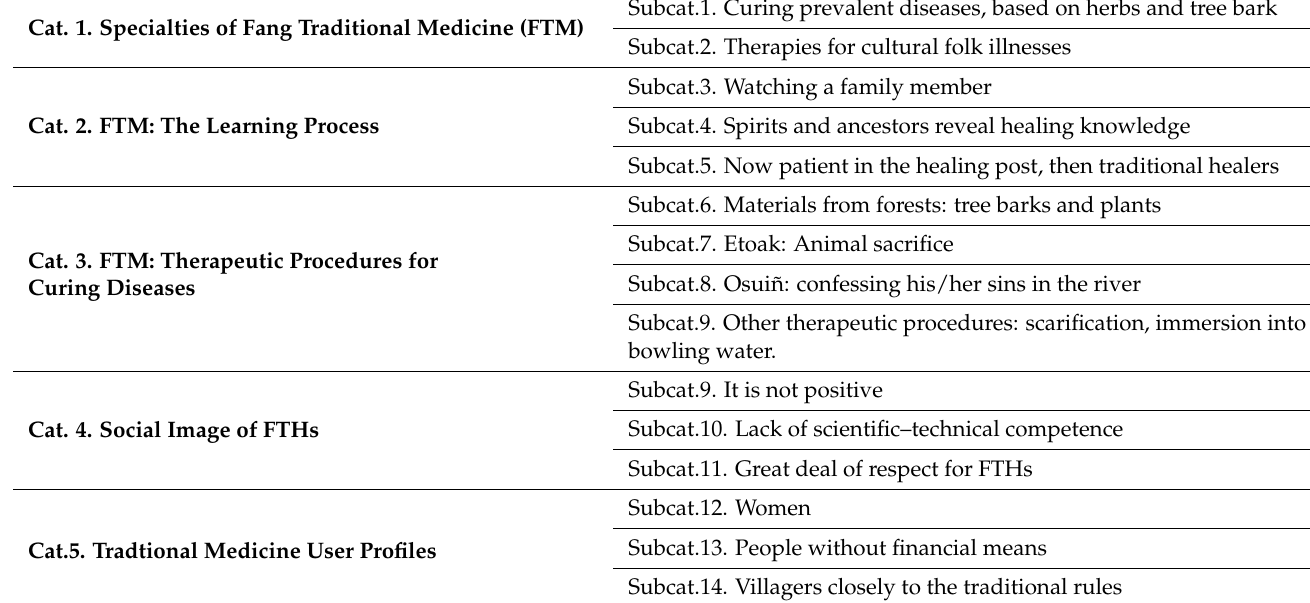
Table 5. Categories (cat.) and Subcategories (sub).